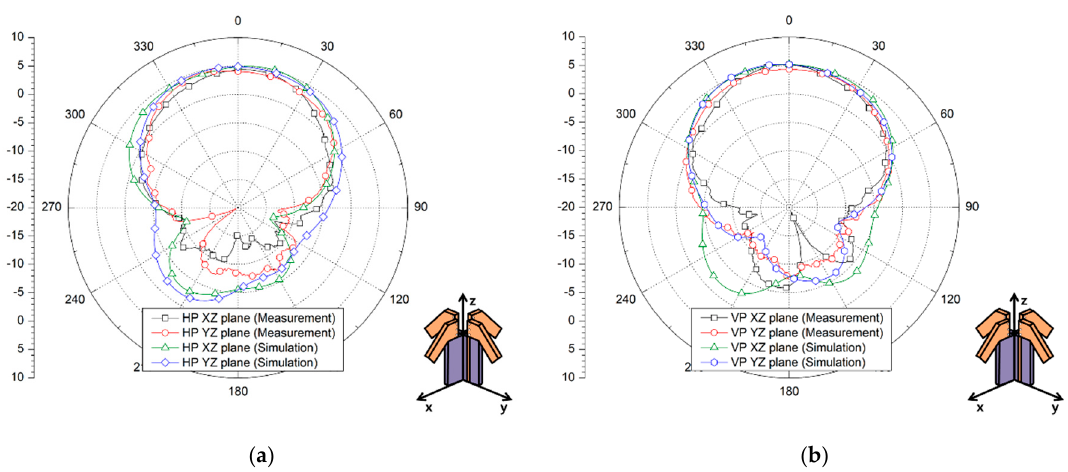
Figure 9. Simulated and measured radiation patterns: ( a ) HP and ( b ) VP on both the xz and yz planes.